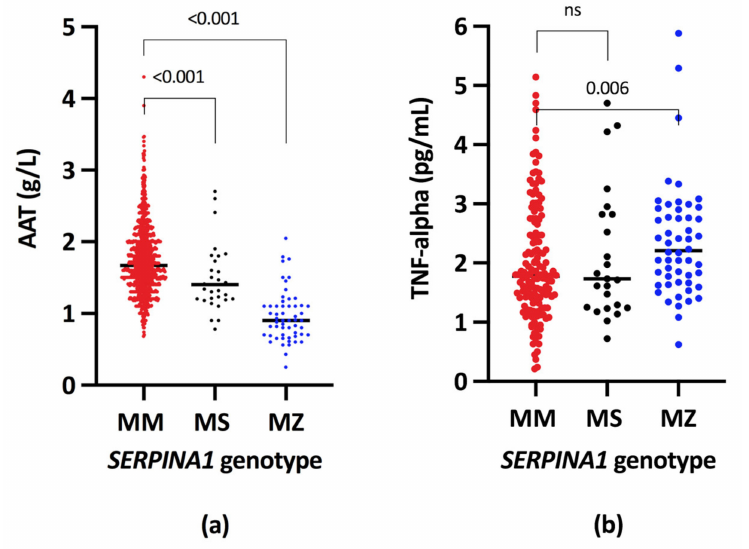
Figure 3. Alpha-1 antitrypsin ( a ) and TNF-alpha levels ( b ) in cirrhotic patients according to the SERPINA1 genotype. AAT, Alpha-1 antitrypsin; TNF-alpha, Tumour necrosis factor alpha.